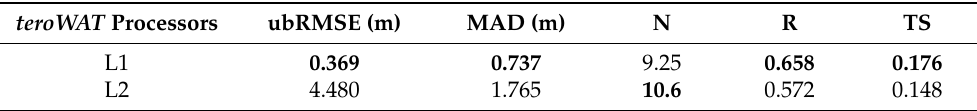
Figure 6. Water level relative change time series in meters for all virtual stations and corresponding in situ stations in the Lena River with ( a ) map with in situ stations (in yellow) and corresponding Vir- tual Station geometries (background from ESRI), ( b ) Batamai, ( c ) Kangalassy, ( d ) Yakutsk, ( e ) Tabaga, ( f ) Pokrovsk close-by station time series. Table 5. Averaged metrics of VSMs for 5 in situ stations (Batamai, Kalangassy, Yakutsk, Tabaga, Pokrovsk) in the Lena River for comparison between L1 and L2 teroWAT processors. The in situ mea- surements are only available until 2020. Bold values represent the best statistically significant